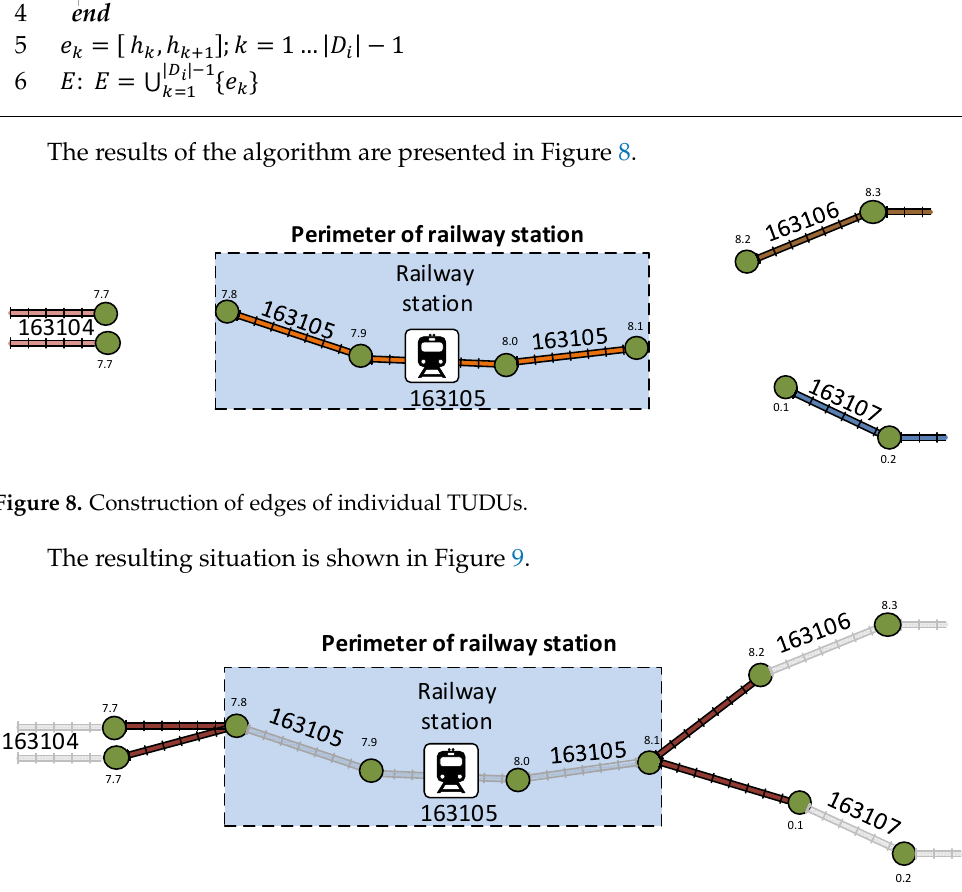
Figure 9. Formation of edges between different TUDUs.